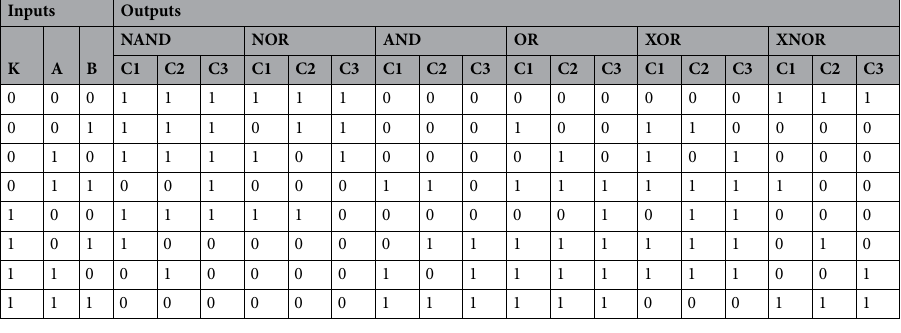
Table 8. Truth-table of proposed